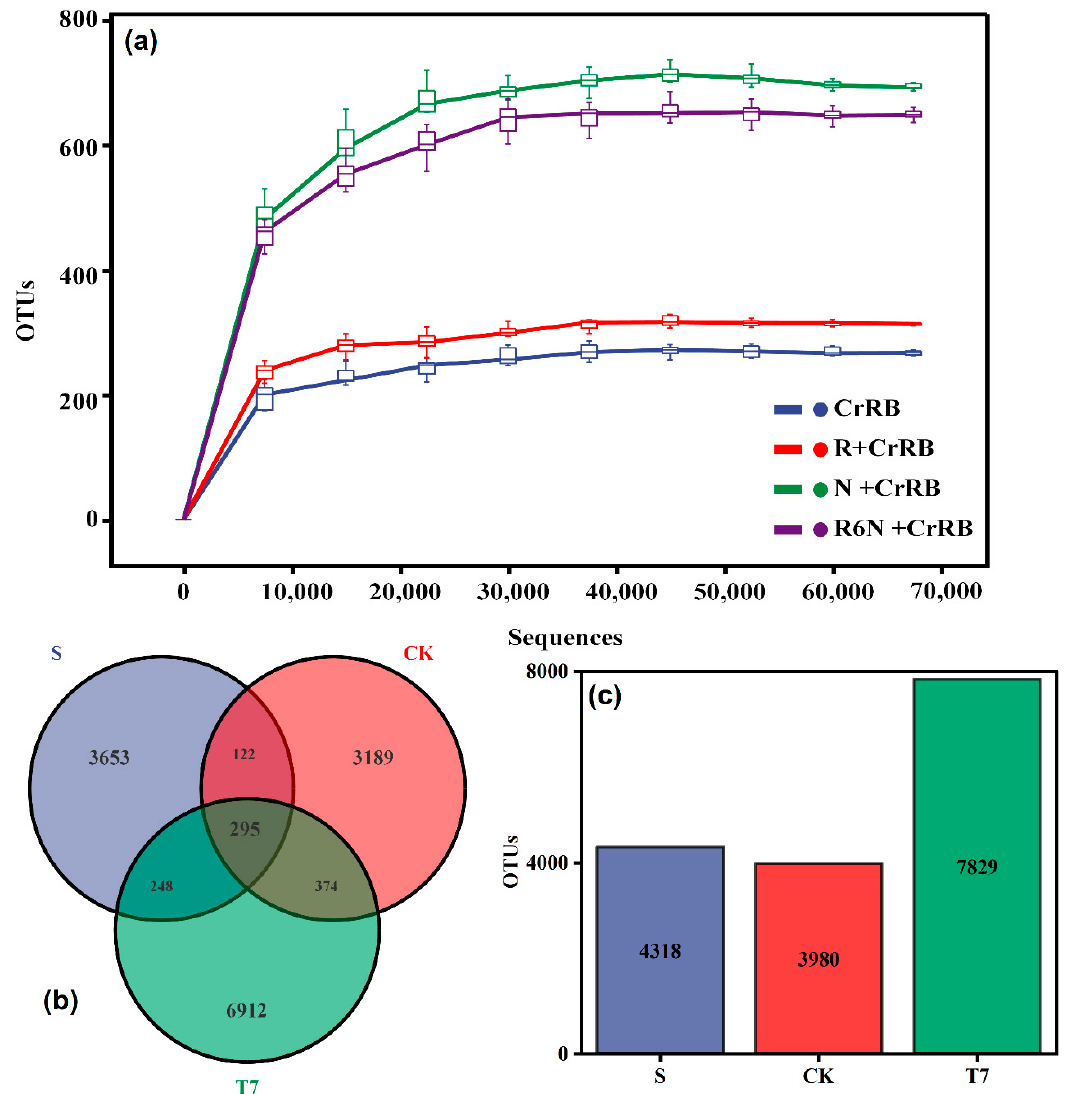
Figure 3. Soil sample bacterial community dilution curve ( a ); Venn diagram ( b ) and number of OTUs ( c ) of bacterial communities in different treatment fractions. (Unactivated original contaminated soil (S), soil without any additive (CK), BC-nZVI, 10 g/kg (T7)).